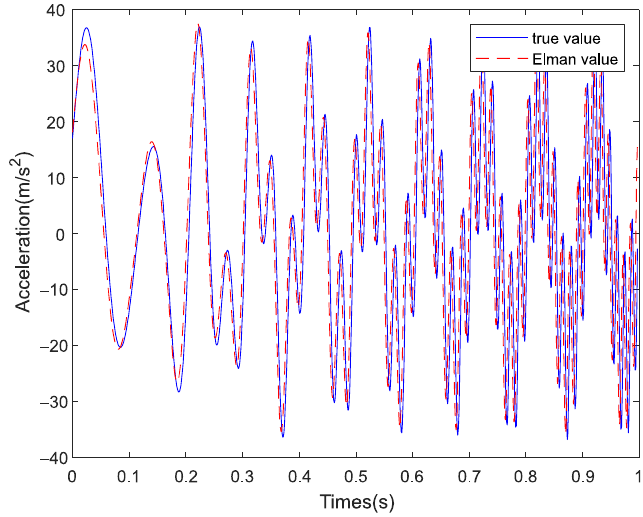
Figure 8. Reconstruction result after EMD decomposition.